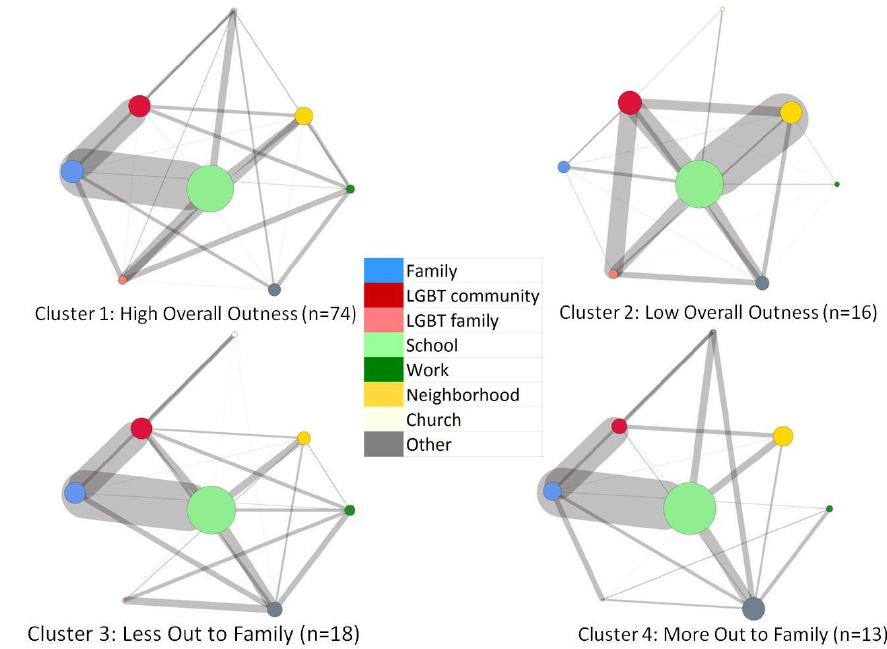
Figure 3. Network composition and connectivity by cluster type. Note: Node size is relative to the proportion of alters in each relational subgroup. Edge size is relative to the proportion of edges between each pair of relational subgroups.